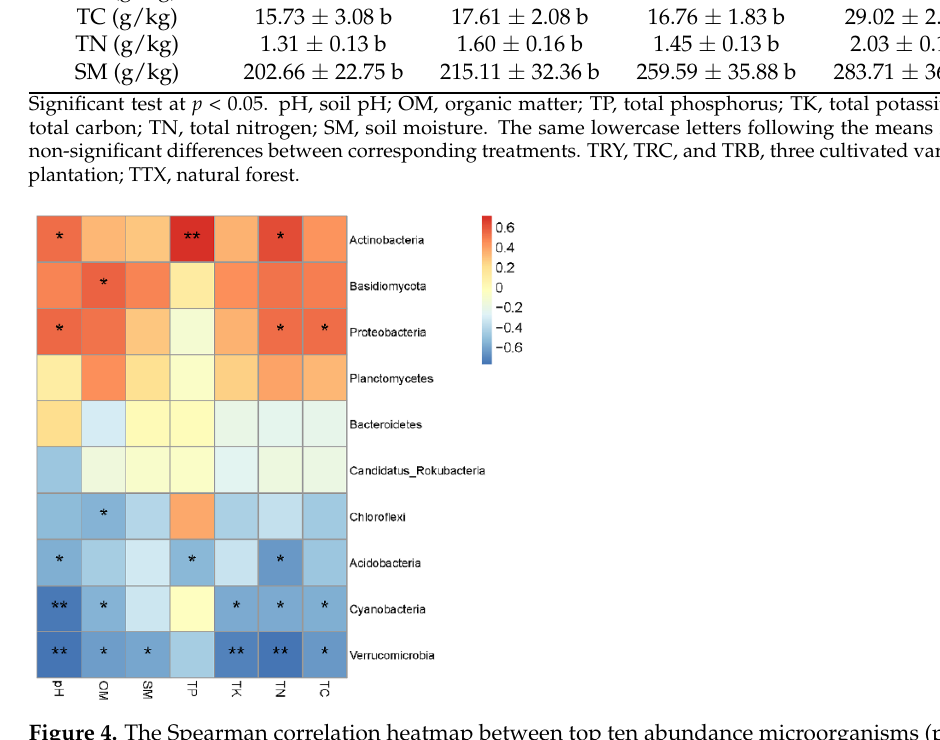
Figure 4. The Spearman correlation heatmap between top ten abundance microorganisms (phylum level) and soil physicochemical characteristics. The size of Spearman correlation coefficient is displayed by color gradient. * Correlation is significant at p < 0.05; ** Correlation is significant at p < 0.01; pH, soil pH; OM, organic matter; SM, soil moisture; TP, total phosphorus; TK, total potassium; TN, total nitrogen; TC, total